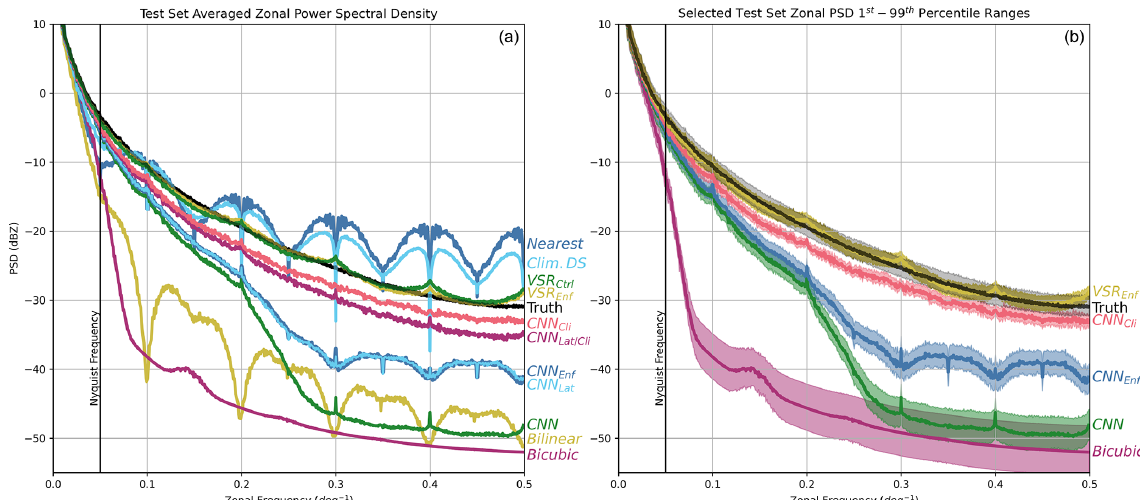
Figure 6. (a) Zonal power spectral density (PSD) curves (averaged meridionally) for outputs from the various downscaling schemes. The black curve shows the PSD of the ground truth data, and close proximity to the black curve indicates that a scheme successfully reproduces the spatial variability of the original data across multiple scales. The vertical black line indicates the highest frequency that can be represented by the coarsened input data. The CNNs that ingest high-resolution climatology data and the VSR CNNs perform the best. Several of the schemes show ringing artifacts due to sharp discontinuities in the output associated with the coarsened grid of the input data. (b) The shaded region indicates the 1st–99th percentile range for PSD curves computed for all samples in the test set, showing the dependence of the result on sample